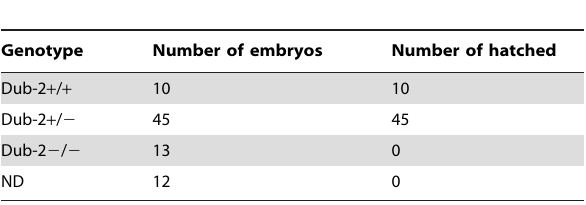
Table 2. The number of hatching status of E3.5 embryos after 96 hrs of culture in vitro